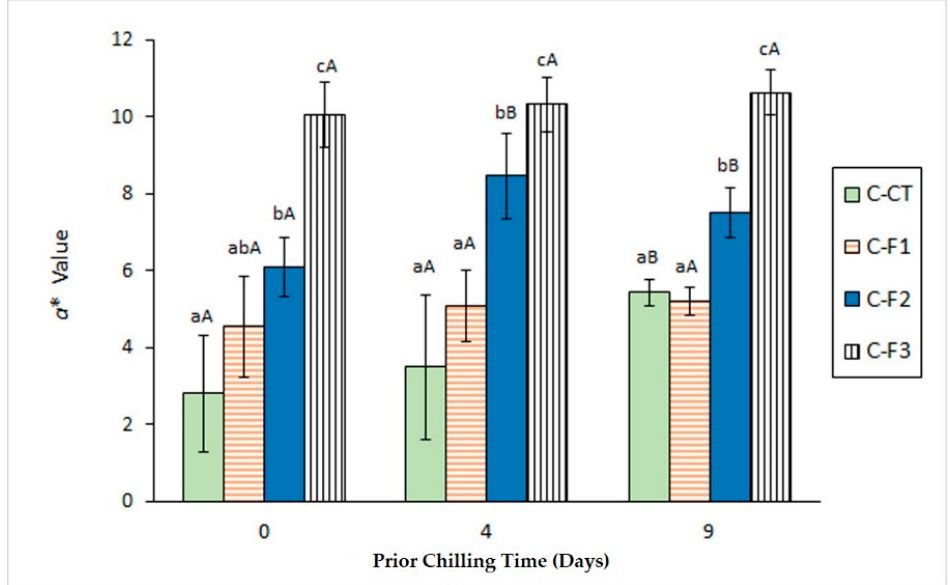
Figure 3. Determination of a * colour value in canned mackerel previously subjected to different chilling times and packaged with different alga extract concentrations. Mean values of five replicates ( n = 5). Standard deviations are indicated by bars. Initial raw fish value: 15.56 ± 3.36. For each chilling time, different low ‐ case letters (a, b, c) denote significant differences ( p < 0.05) as a result of the alga extract concentration. For each alga extract concentration, different capital letters (A, B) denote significant differences ( p < 0.05) related to the chilling time. Alga extract concentrations in packaging media as indicated in Figure 1.